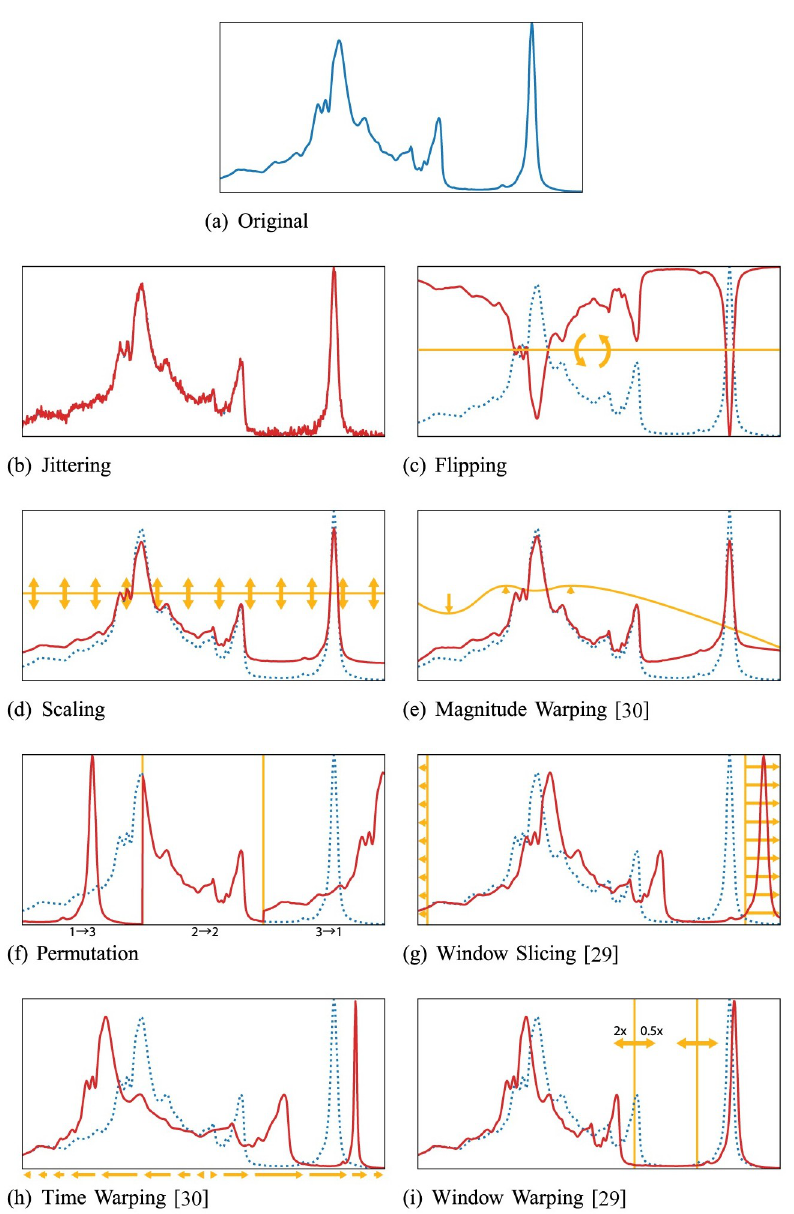
Fig 1. Examples of random transformation-based data augmentation on the OliveOil dataset. The dotted blue lines are the original patterns and the solid red lines are the generated patterns.